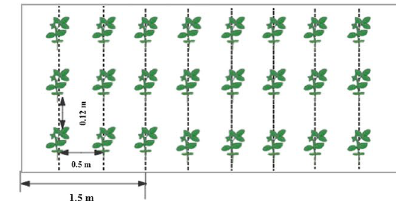
Figure 1. Schematic diagram of different cultivation practices. ( a ) alternating ridges and furrows with ridges mulched with white polyethylene film (PMP). ( b ) Alternating flat and bare land with only the plat mulched by white polyethylene film (PMF). ( c ) Alternating strips mulched with maize ( Zea mays L.) straw (SM). ( d ) Traditional land planting without mulching